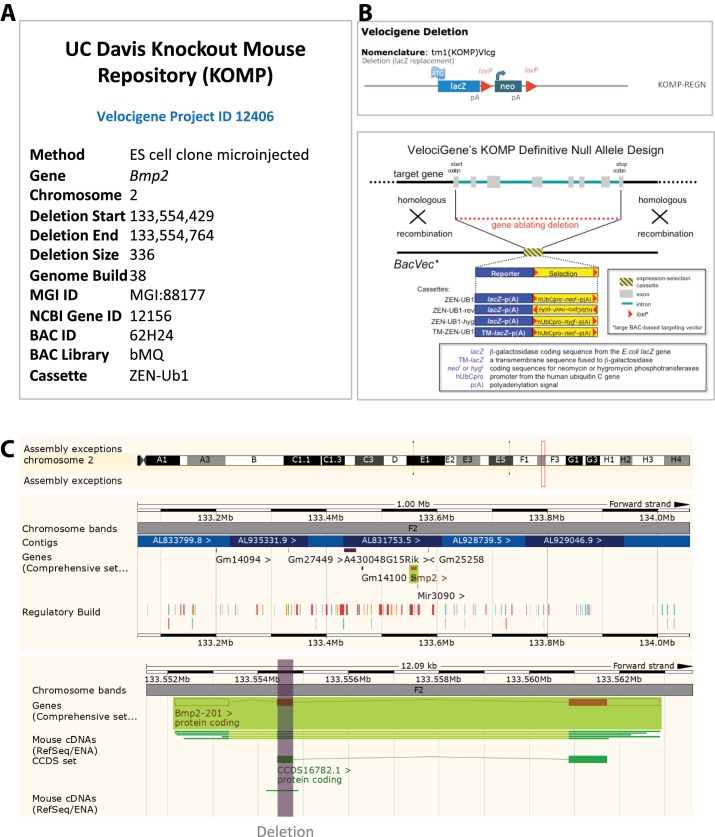
Schematic of the Bmp2lacz knock-in allele.Homologous recombination was used to replace the first 336 coding nucleotides of murine Bmp2 with non-membrane targeted bacterial beta-galactosidase. (a) Specifics of allele construction from the UC Davis Knock Out Mouse Project repository, Velocigene project ID 12406. (b) Schematic of the targeting strategy and the ZEN-Ub1 replacement cassette. (c) Genomic view of targeted locus visualized with the publicly-available Ensembl genome browser (www.ensembl.org).